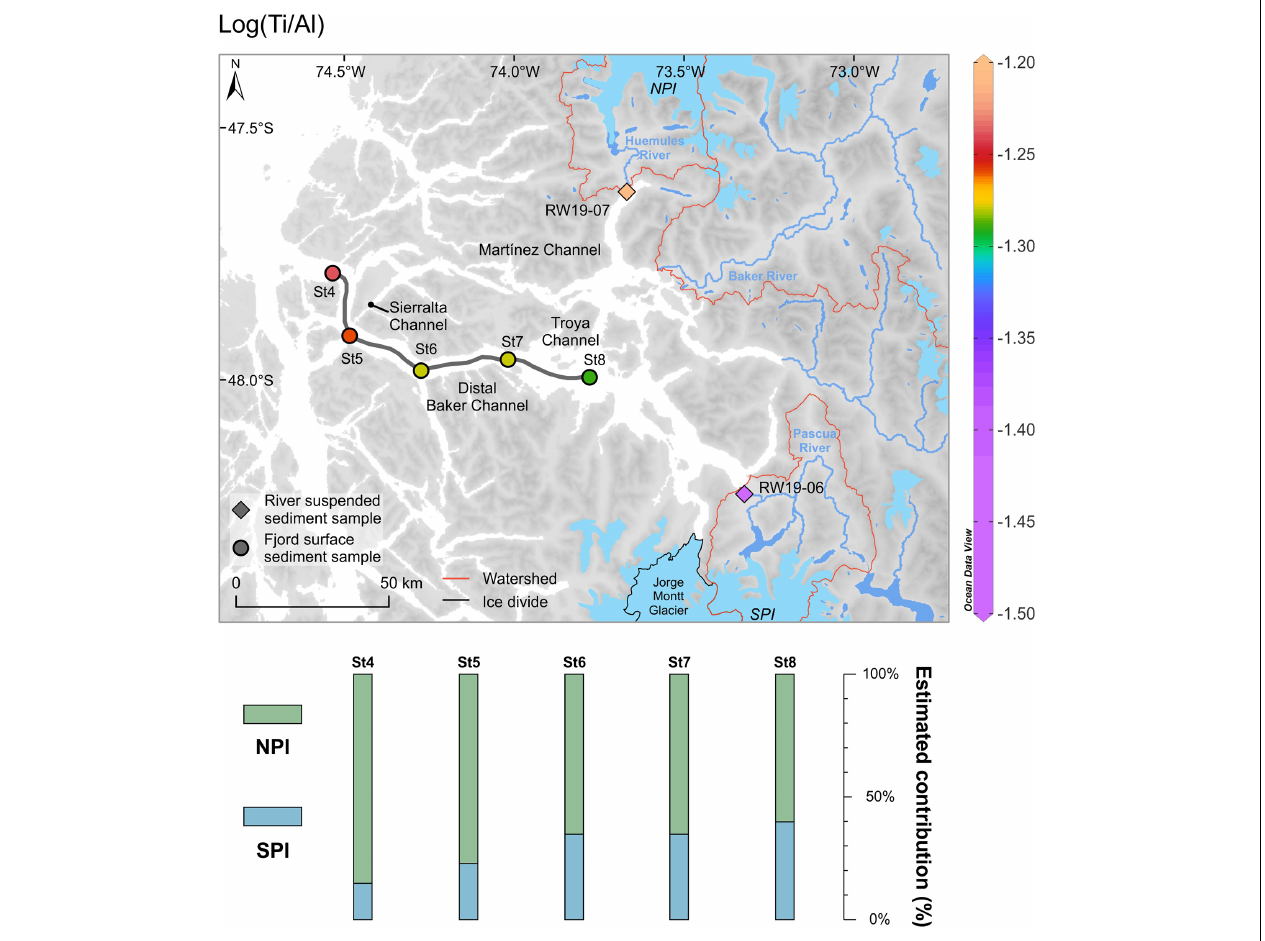
FIGURE 9 | Relative contributions of NPI- and SPI-derived sediments to the distal part of Baker Channel, as estimated by linear mixing based on log(Ti/Al). NPI sediments mostly originate from the Huemules and lower Baker River watersheds, whereas SPI sediments mostly represent sediment input from Jorge Montt Glacier and from the lower Pascua River watershed. RW19-07 and RW19-06 were used to define the NPI and SPI